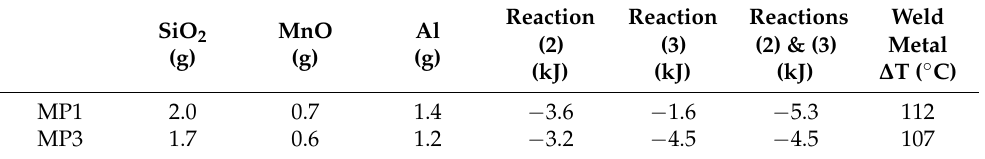
Table 6. Exothermic heat from aluminium reduction reactions (2) and (3).